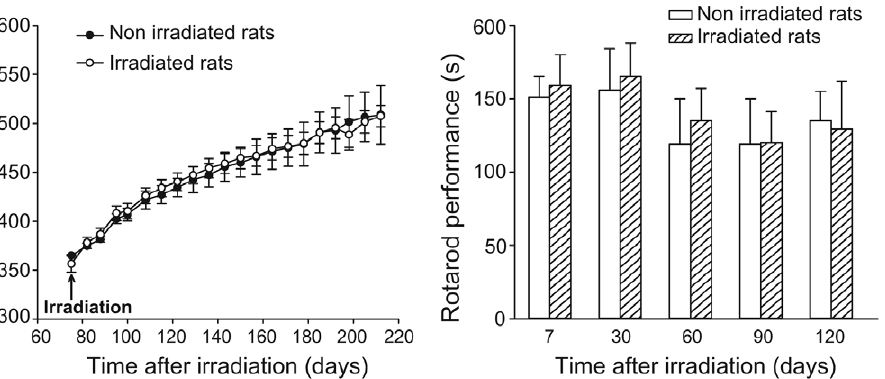
Figure 4. Weight trend and rotarod performance of healthy non-irradiated and irradiated rats. Data are means + S.E.M. (n=3 for non- irradiated rats and n=12 for irradiated rats).